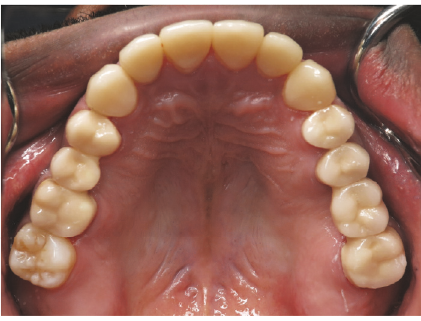
Figure 8: Zirconia crown and bridges on restoring maxillary arch.